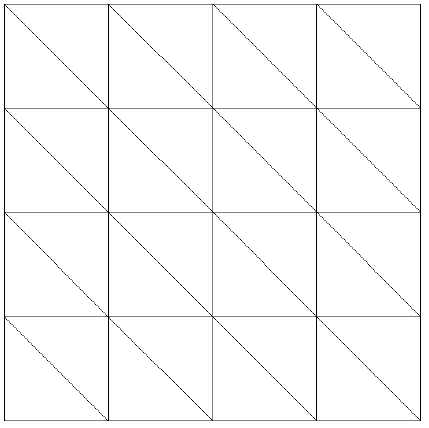
Figure 4. Mesh of one quarter of a square plate (4 × 4).